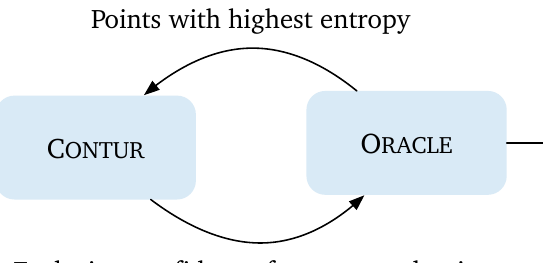
Figure 1: High-level overview of the C ONTUR O RACLE workflow. The standard C ONTUR programme is used to determine CL exclusions for points in the parameter space. This s information is provided to the O RACLE module which trains a random forest classifier to make predictions of the CL exclusions for arbitrary points. Those points with the s highest entropy—a measure of lack of confidence of the classifier in its predictions— are then sampled by C ONTUR and the process is repeated until pre-defined stopping conditions are met. The CL exclusions for a grid of points in the parameter space are s then returned to the